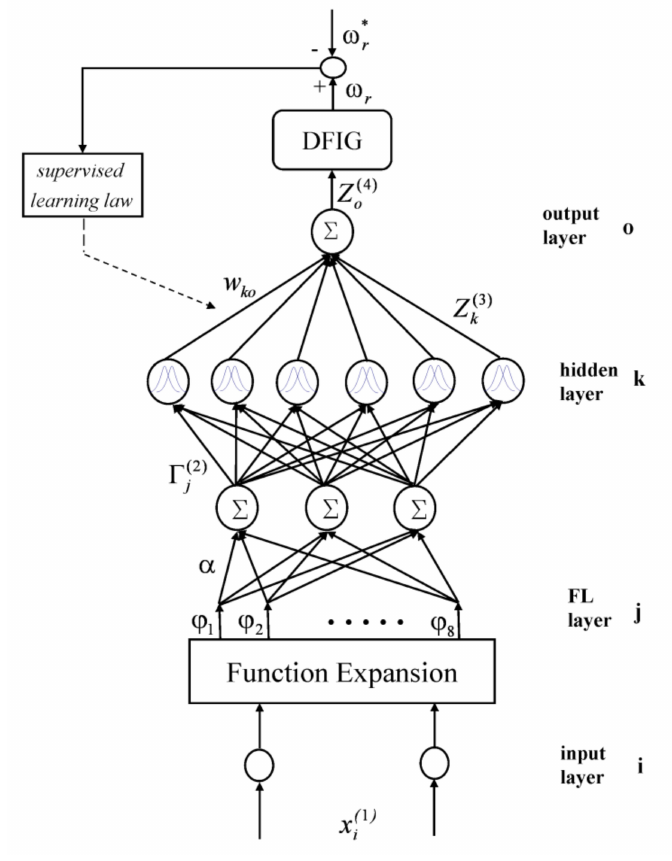
Figure 2. The structure of a